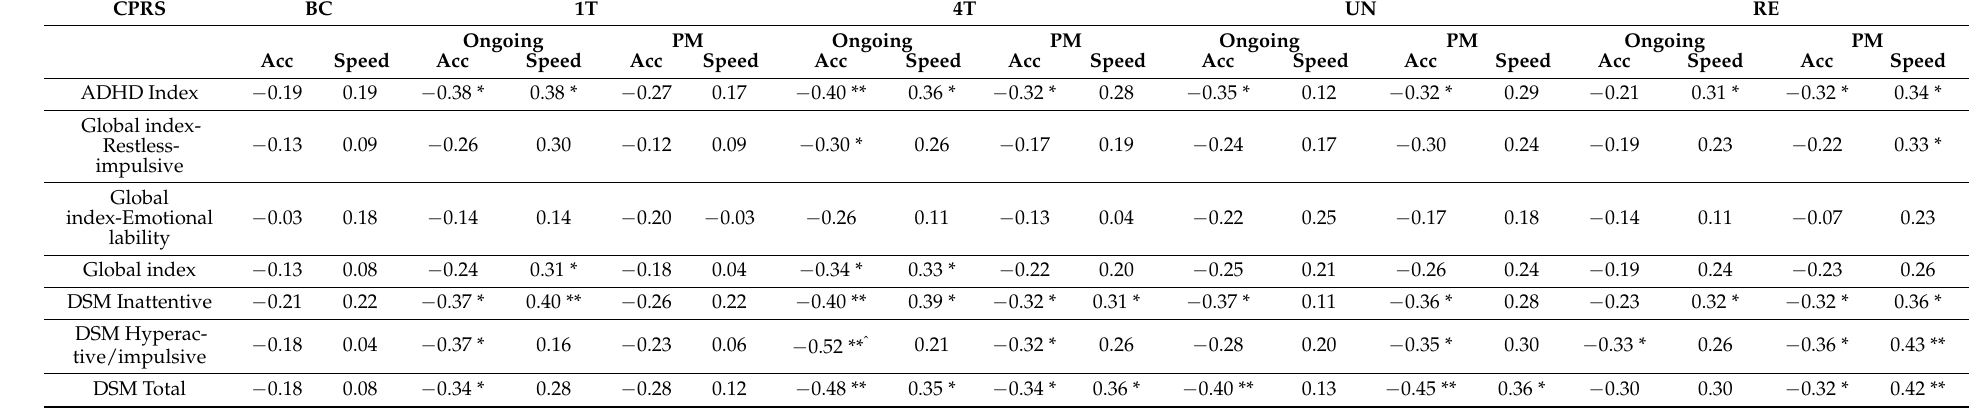
Table 2. Correlational analysis between the results in the experimental paradigm and the global indexes of the Conner’s Parent Rating Scales in both the studied groups. CPRS BC 1T 4T UN RE Ongoing PM Ongoing PM Ongoing PM Ongoing PM Acc Speed